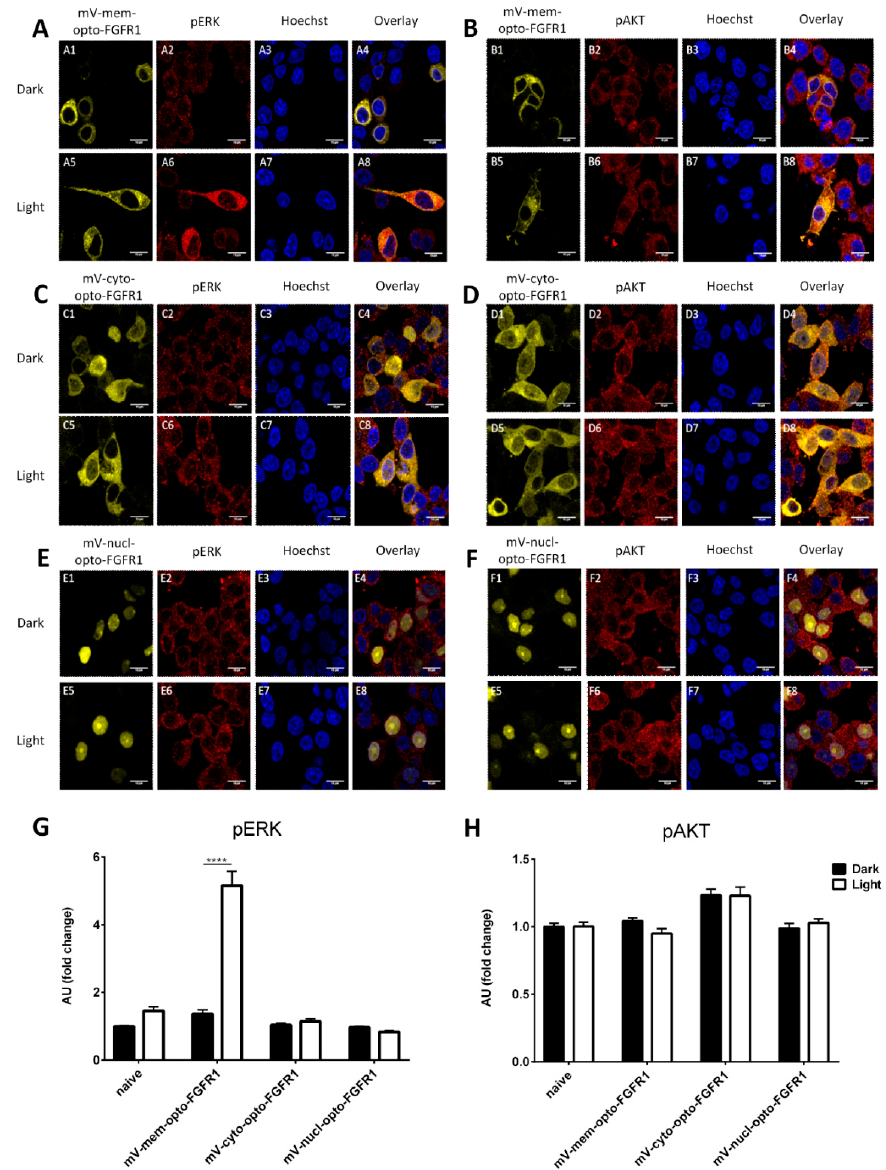
Figure 4. Light-induced ERK and AKT activation in mV-opto-FGFR1-transfected PC12 cells. Although mV-mem-opto-FGFR1-transfected cells exhibit short neurite extensions (sprouts) in the dark (A1), blue light induces neuronal differentiation with long, slender neurites in transfected cells